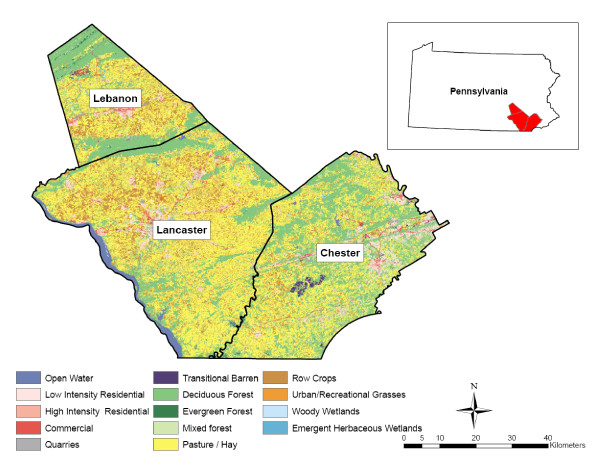
Land use in 1992 in the three study area counties in southeastern Pennsylvania. Data from Principal Aquifers of the 48 Conterminous United States, Hawaii, Puerto Rico, and the U.S. Virgin Islands: U.S. Geological Survey. Madison, WI; 2003